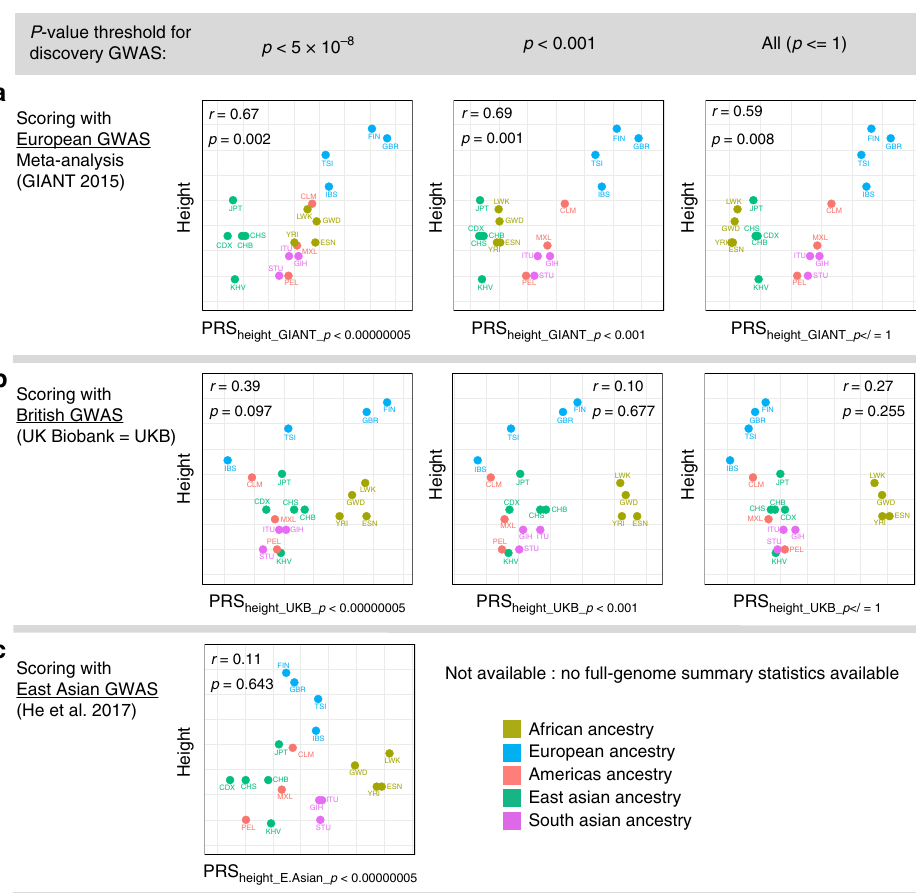
Fig. 4 Scatterplots of height polygenic scores ( x -axis) and phenotypic height ( y -axis). Plots demonstrate that correlations between polygenic scores for height and height are not consistent across discovery GWAS. The y -values for height are the same for each plot and re fl ect average height of individuals in the country of origin for each population included. Average heights ( y -axis) are from a different height GWAS used to construct polygenic scores ( x -axis). Three different GWAS of height were used (i.e., three rows) with three different p -value thresholds (i.e., three columns) for the construction of polygenic scores. a GIANT-based polygenic scores for height. b UK Biobank-based polygenic scores for height. c East Asian based polygenic scores for height. The last two plots are missing because only genome-wide signi fi cant variants were available for the East Asian GWAS of height. p and r values for each plot are for correlation tests between polygenic scores for height ( x -axis) and height ( y -axis). GWAS = genome-wide association study, GIANT = Genetic Investigation of ANthropometric Trait, PRS = polygenic risk score, population abbreviations within scatterplots are those used by the 1000Genomes Consortium and are available in Supplementary Table